Question: How would you classify this visualization?
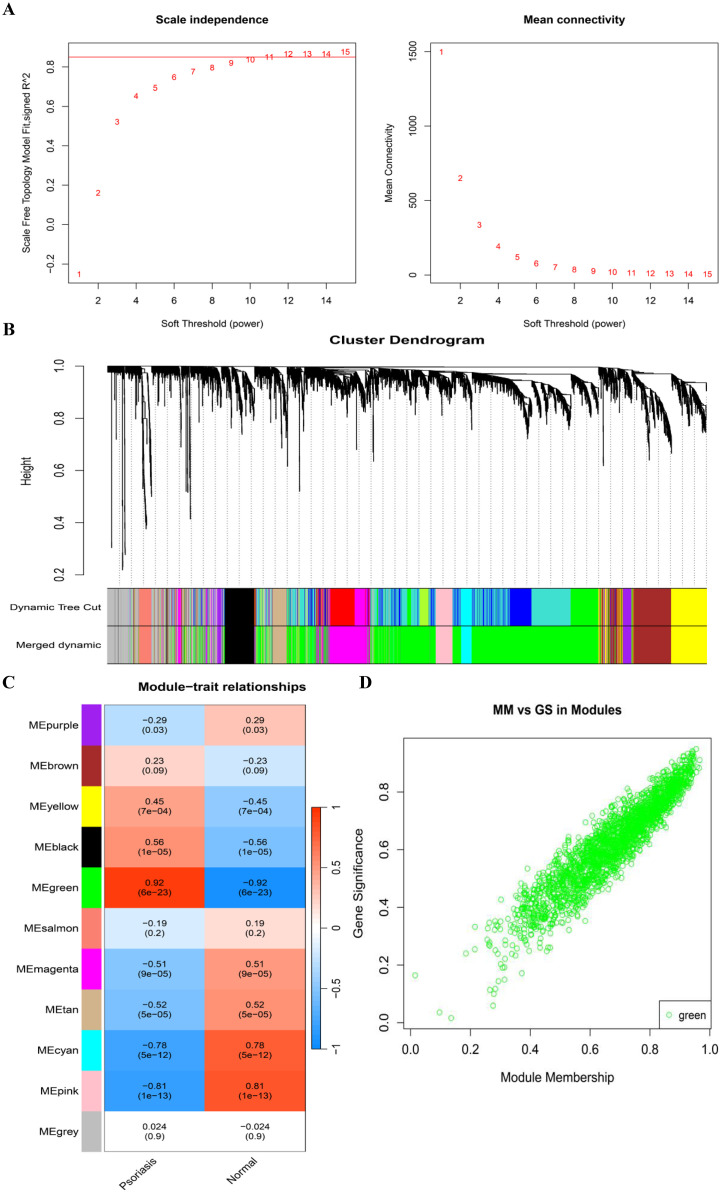
Answer: heatmap